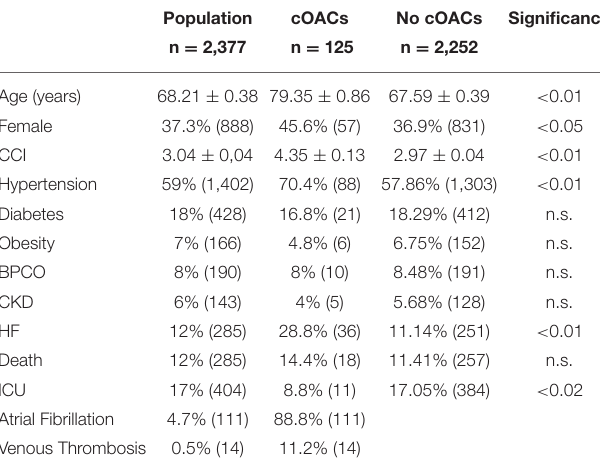
TABLE 1 | Clinical Characteristics of study population.